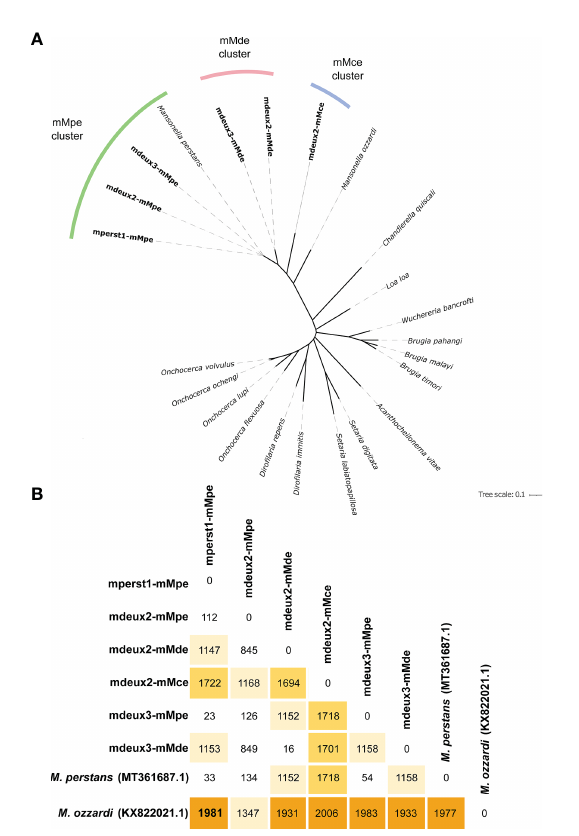
FIGURE 3 Mitogenome analysis. (A) Mitogenome phylogeny of different nematode species, including the newly generated mitogenomes from the three assemblies forming three Mansonella mitogenome clusters: Mitogenome of M. perstans mMpe marked in green, comprising of the mitogenomes from mperst1, and additionally two mitogenomes at low coverage of the individuals mdeux2 and mdeux3. Mansonella sp “ DEUX ” mMde marked in orange, with two mitogenomes of high coverage of mdeux2 and mdeux3. And the surprising third mitogenome of “ M. cermeli ” mMce with a single mitogenome of individual 2 (mdeux2). (B) SNP variant call between the three mitogenomes of each individual generated by us and the published mitogenomes of M. perstans (GenBank: MT361687) and M. ozzardi (GenBank: